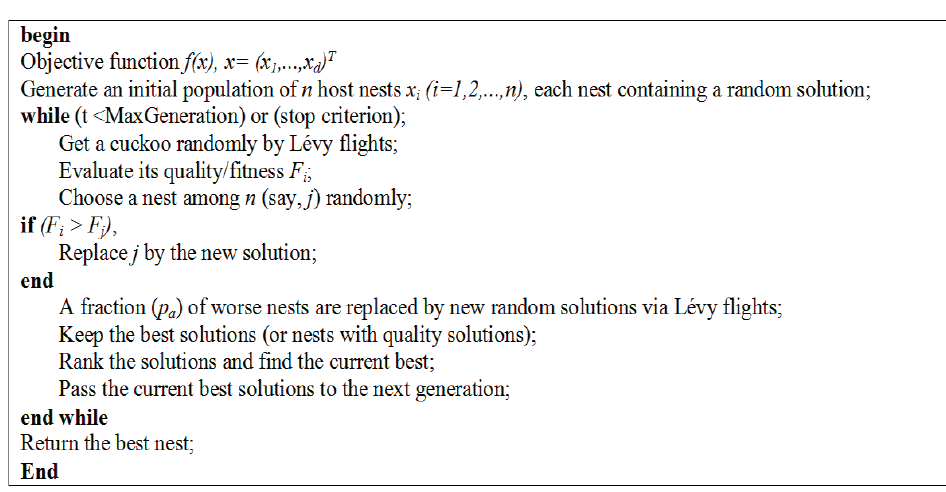
Figure 1. Pseudo code of the Cuckoo Search